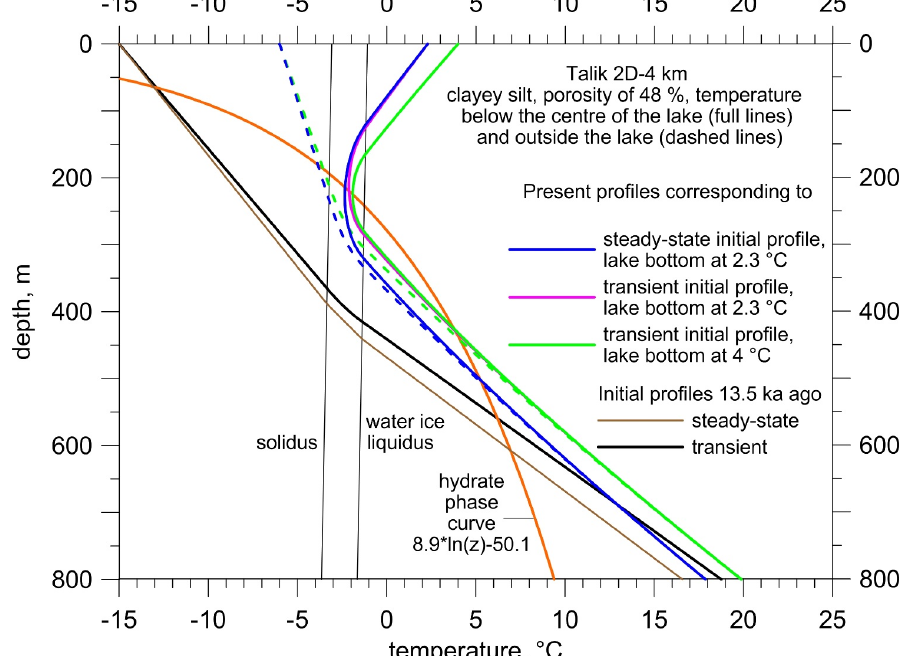
Figure 13. Current temperature–depth profiles and permafrost and GH stability for the range of temperature at the lake bottom 2.3 °C–4 °C. A model of a 2-D lake of 4 km width, 48% porosity clayey substrate for both the steady-state and transient temperature